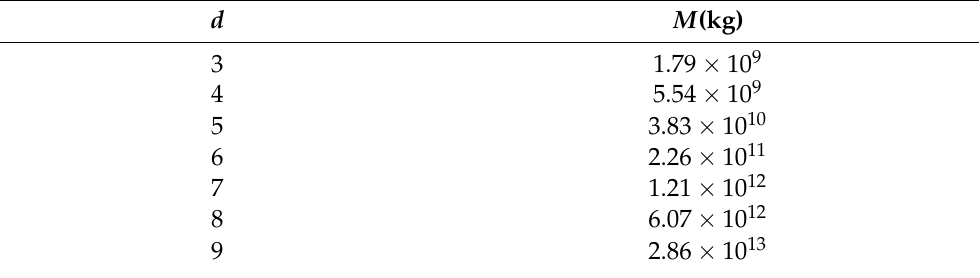
Table 3. Lower bound on the mass of the black hole